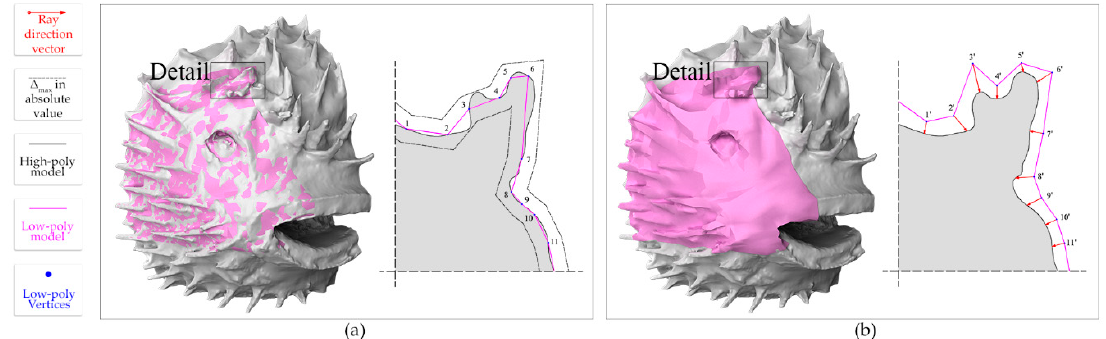
Figure 15. Two approaches to baking: conventional ( a ) and with a ‘cage’ (or projection cage) ( b ). The latter can supply baking process with a better flow of the vertex normals.